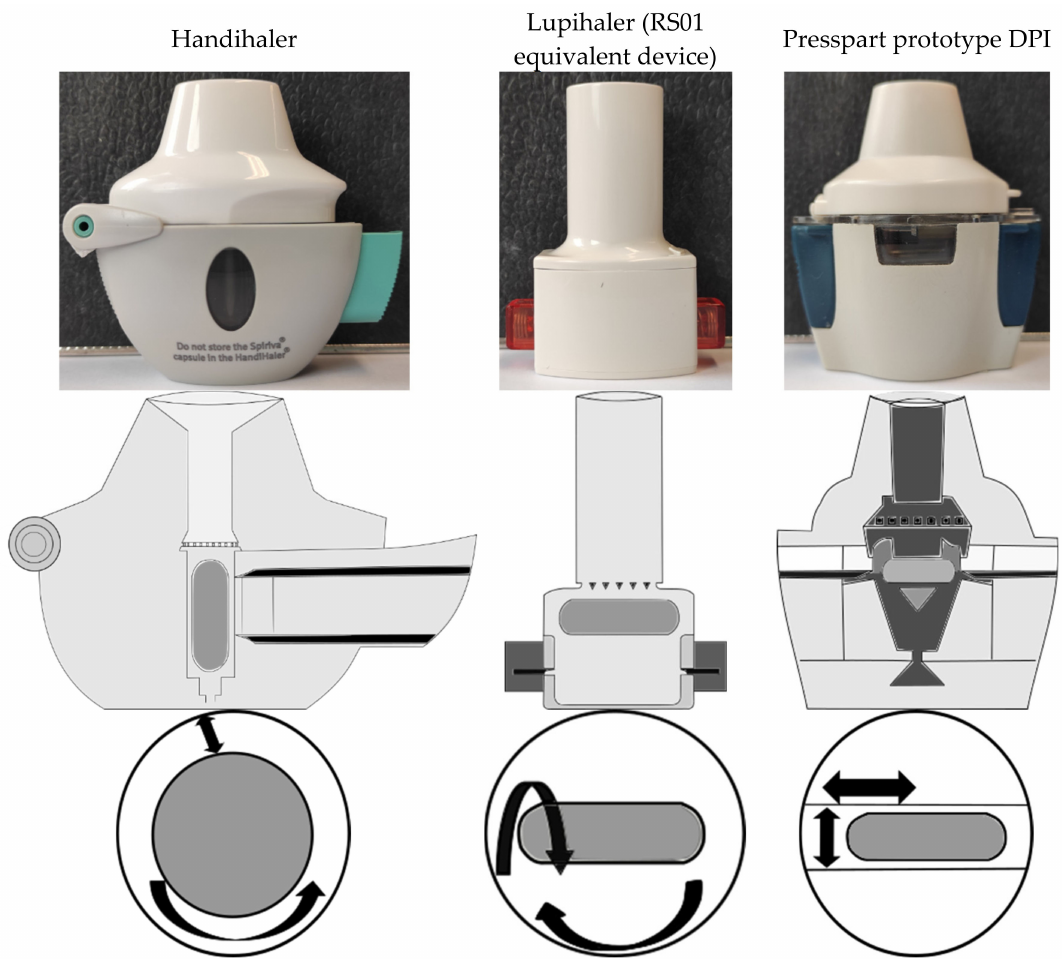
Figure 1. Schematic representation of the tested dry powder inhalers (DPIs) and the possible capsule movements that can be achieved in the various DPIs during inhalation. Modified from